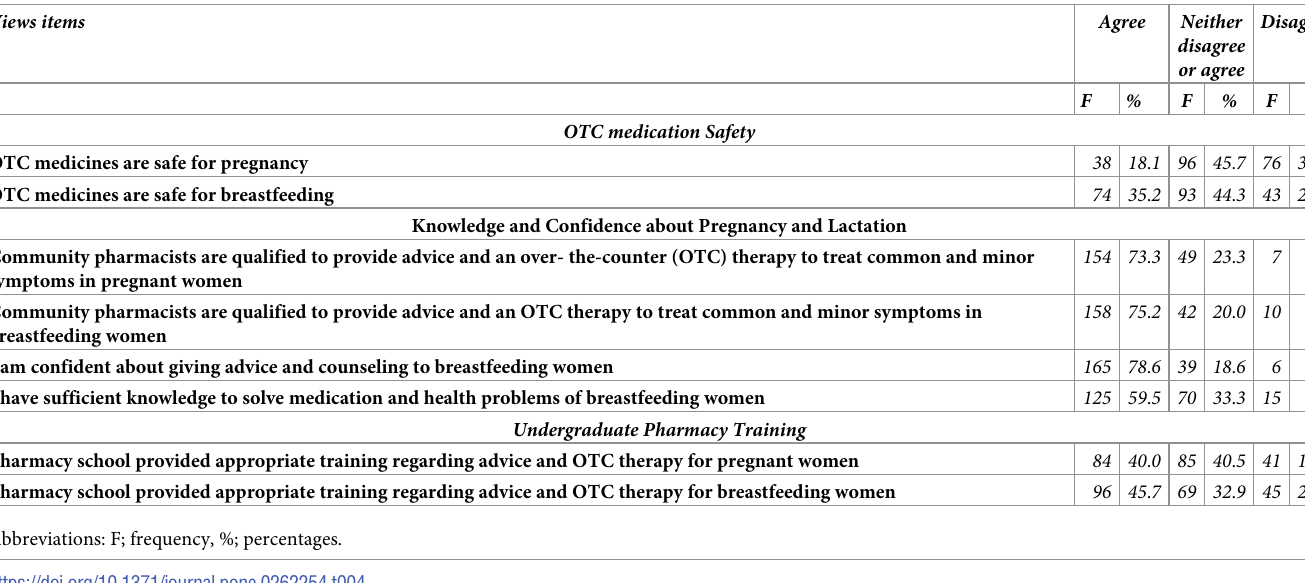
Table 4. Number and percentage of the questions regarding pharmacists’ views about self-care in pregnancy and lactation. Views